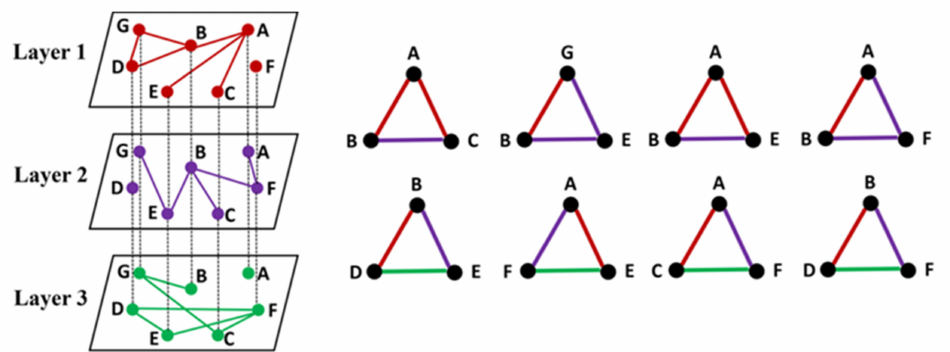
Figure 2. The formation of triangles in a multilayer network. On the right side of the figure are two rows of triangles, each representing one case. For the first case, the sides of the triangle are made up of two layers. Taking nodes A, B, and C as examples, node B and node C in layer 1 belong to the neighbor nodes of node A, but there is no connecting edge between node B and node C. The connection edge between them is detected in layer 2. In this case, the nodes A, B, and C form a closed triangle in the multilayer network. A similar phenomenon can be observed for other triangles of the first type. In the second case, the sides of the triangle span three different layers. Taking nodes B, D, and E as an example, nodes B and D are connected at layer 1 but not at other layers, nodes B and E are connected at layer 2 but not at other layers, and nodes D and E are connected at layer 3 but not at other layers. In this case, the nodes B, D, and E form a closed triangle in the multilayer network. A similar phenomenon can be observed for other triangles of the second